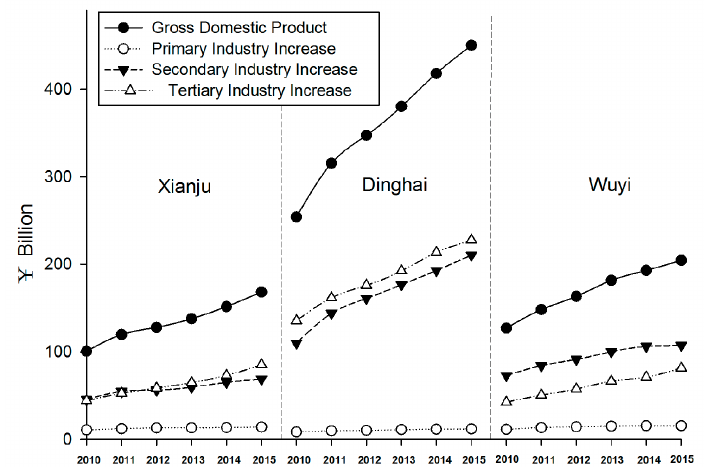
Figure 12. Industrial structure change in study area from 2010–2015.